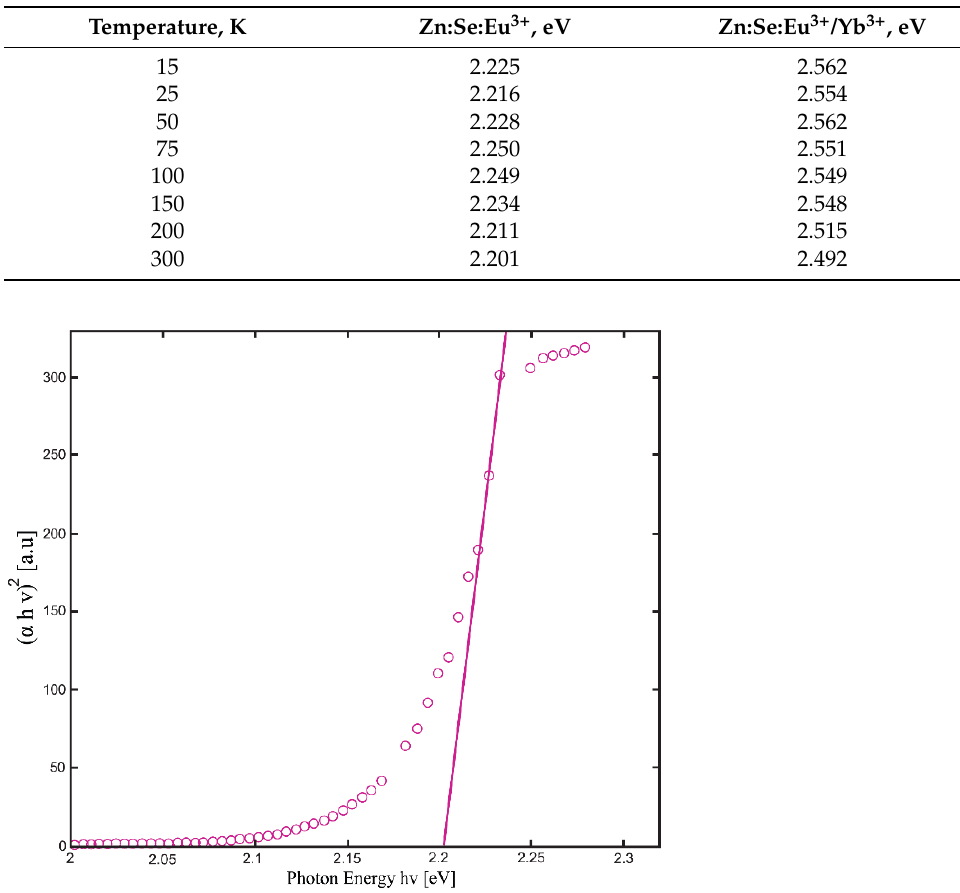
Table 1. Values of the direct band gaps of samples at different temperatures by UV–Vis spectropho- tometry and Kubelka–Munk theory.